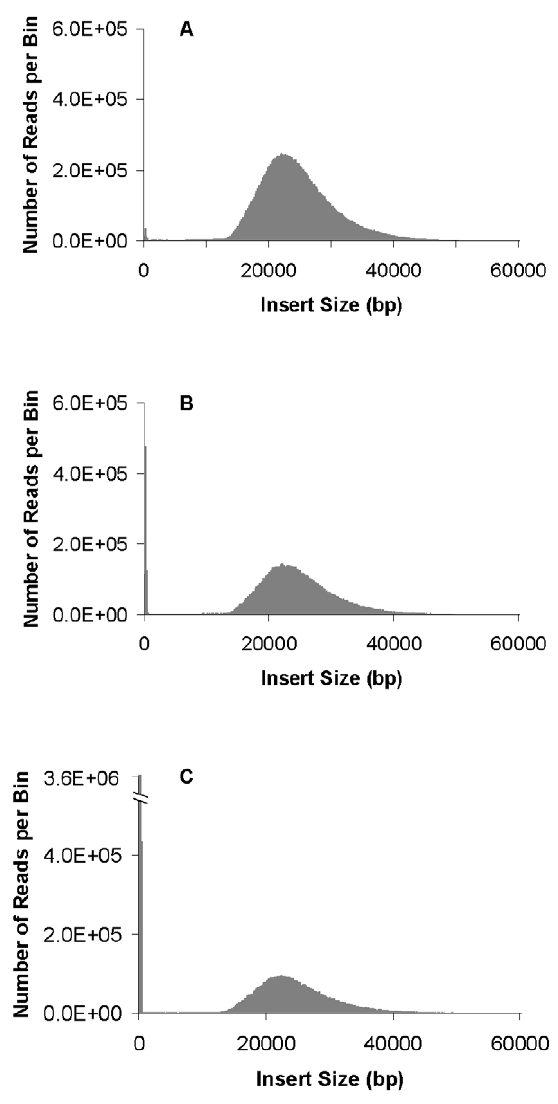
Figure 4. Histogram of insert sizes from Saccharomyces cerevisiae Illumina 22 kb CLIP-PE libraries. A: cut with NlaIII, B: cut with HpyCh4IV, C: random shearing approach. The distribution of insert lengths was determined by aligning the reads to the reference genome.